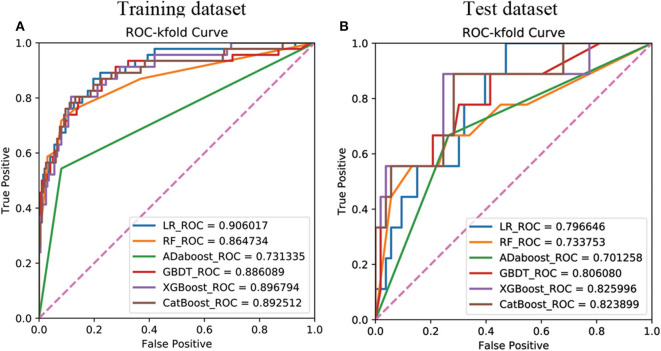
Receiver operating characteristic curves showing the delayed remission predictive performance of six machine learning algorithms based on the selected significant features in the training (A) and test (B) datasets. LR, logistic regression; GBDT, gradient boosting decision tree; XGBoost, extreme gradient boost; AdaBoost, adaptive boosting; CatBoost, categorical boosting.